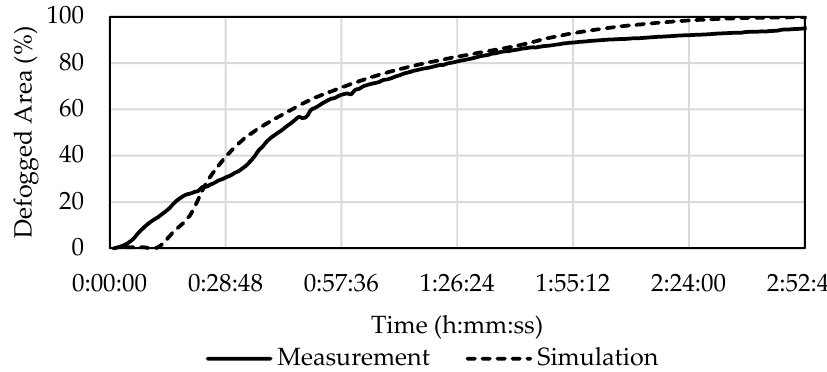
Figure 13. Development of defogging in C2 according to the experiment and the simulation.